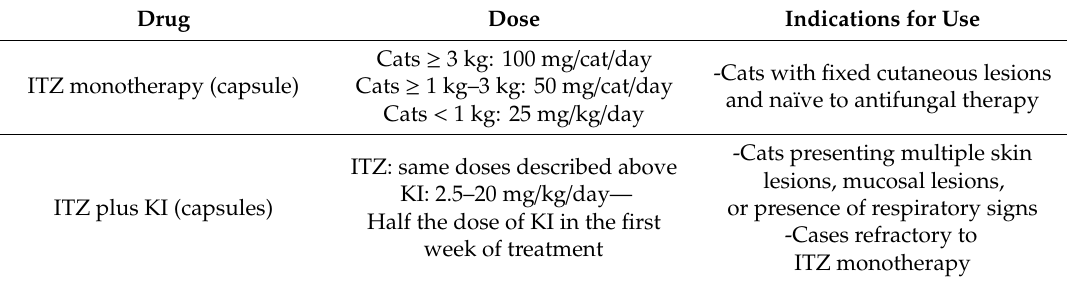
Table A2. Doses of itraconazole monotherapy or combination therapy with potassium iodide recommended in cases of feline